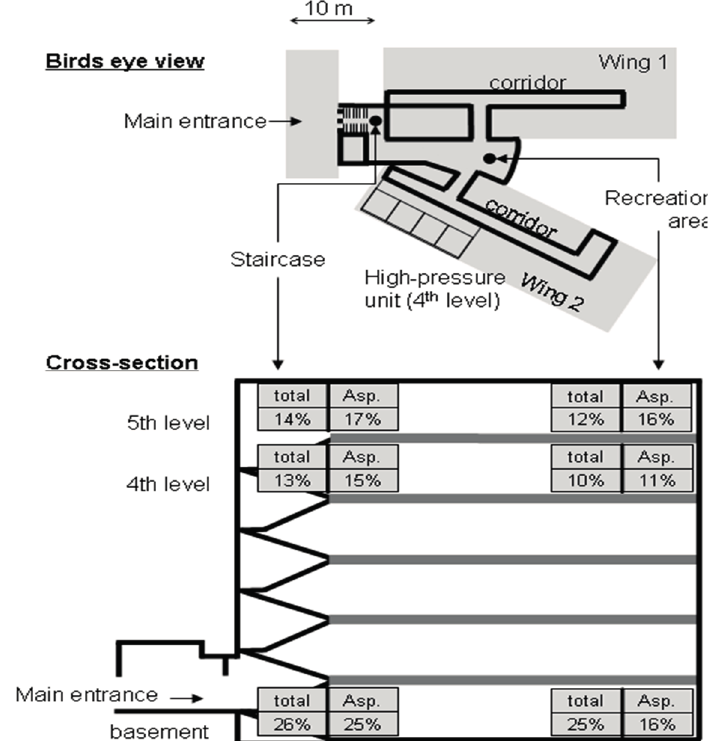
Figure 2. Overview of the study site: Birds eye view ( upper panel ): The black points show the sampling locations in the stair case and the recreation room and on the 4th level the HEPA air-filtered high pressure unit. Cross-section of the building ( lower panel ): The six sampling sites are indicated with grey boxes. The detection rates, in percentages, of all cultivable fungi (total) or Aspergillus spores (Asp.) are